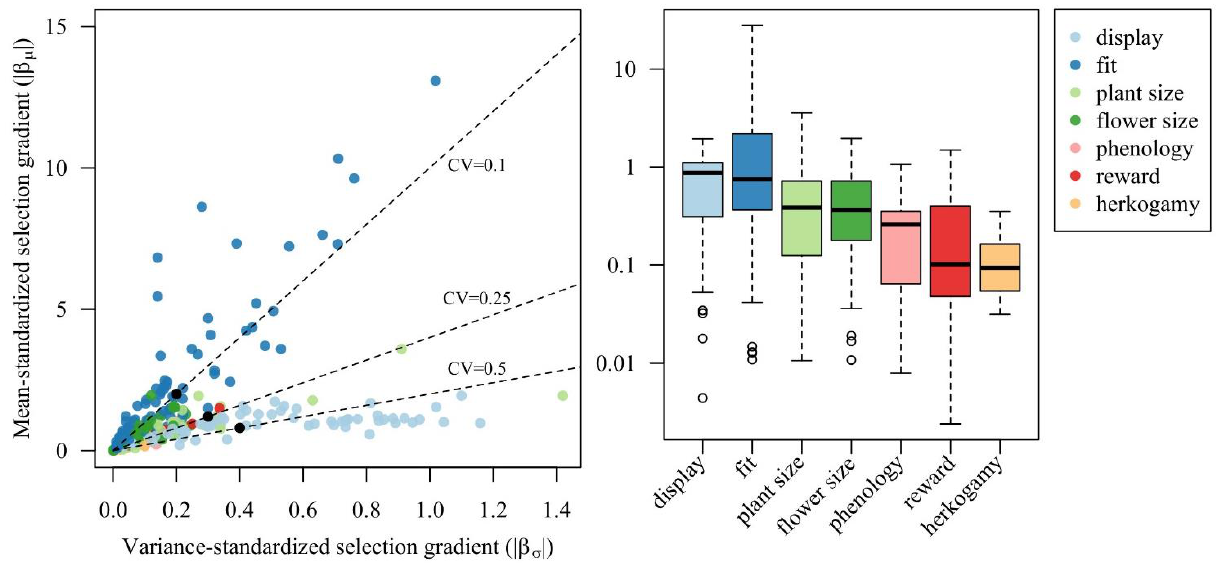
Figure 2. (A) Scatterplot of absolute mean-standardized and variance-standardized multivariate selection gradients on plant traits, with colours representing distinct trait functional groups. Variance-standardized gradients describe the change in relative fitness per standard deviation change in the trait and mean-standardized gradients describe the change in relative fitness per change in the trait mean, with a value of 1 corresponding to the strength of selection on relative fitness as a trait. Dotted lines illustrate how the relationship between variance-standardized and mean-standardized gradients vary with the coefficient of variation (CV) of the trait. The black dots represent three hypothetical traits which rank opposite for the two measures of selection strength, with variance-standardized gradients of 0.2, 0.3 and 0.4 corresponding to mean-standardized gradients of 2, 1.2, and 0.8. (B) Distribution of absolute mean-standardized selection gradients across trait functional